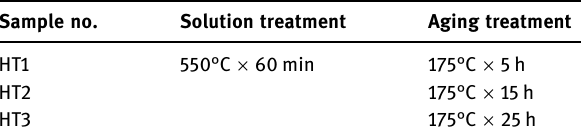
Table 2: PWHT procedure of joint Sample no.